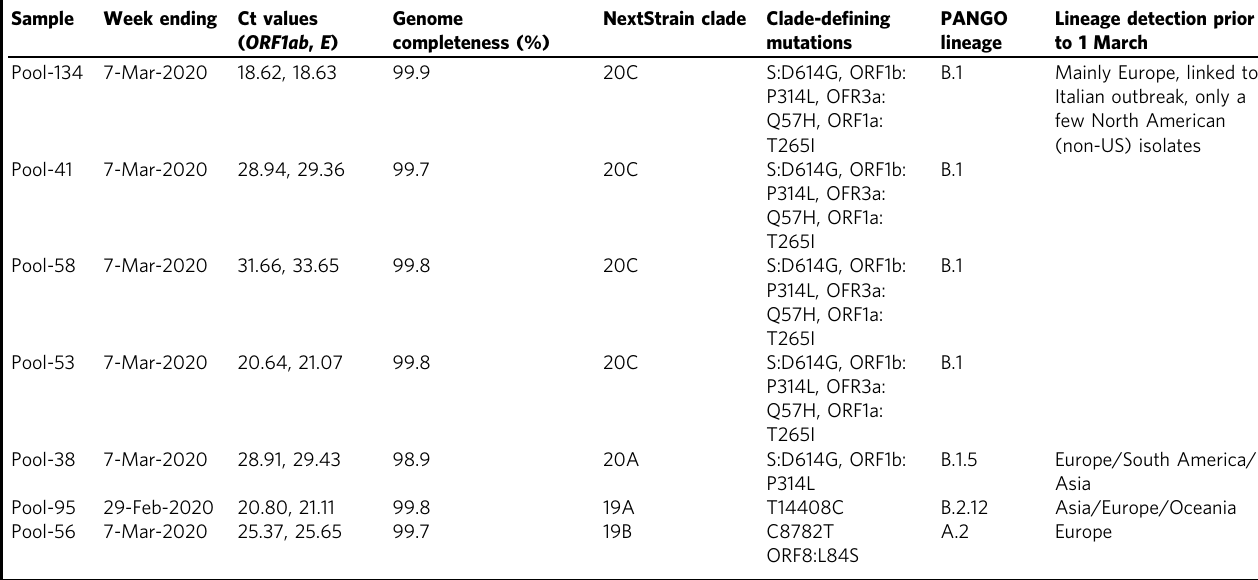
Table 1 Lineage classi fi cation of previously undetected SARS-CoV-2 in NYC.